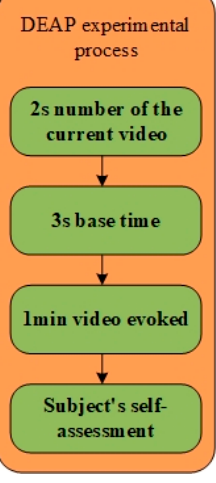
Figure 5. DEAP experimental process.